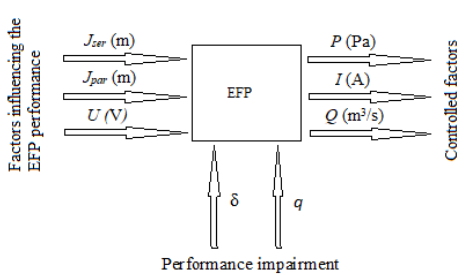
Figure 5. Scheme of the three-factor experiment